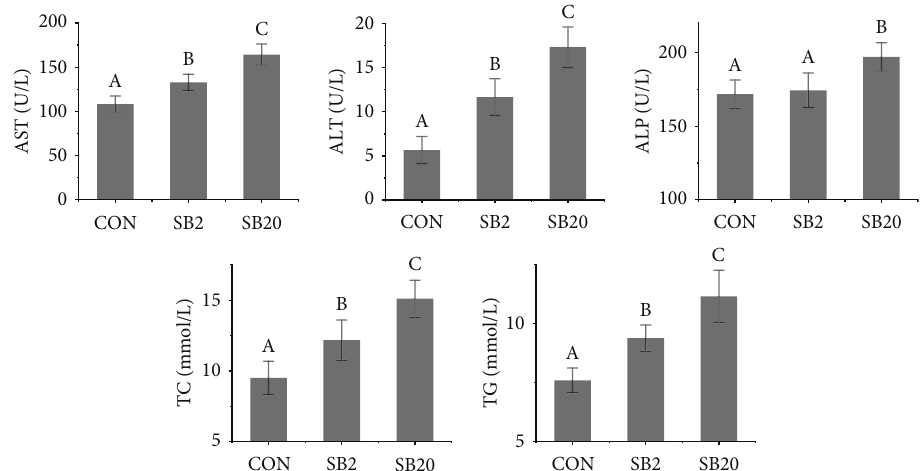
Figure 1: Four e ff ects of two dosages of sodium butyrate on serum biochemistry of largemouth bass, Micropterus salmoides. AST: aspartate aminotransferase; ALT: alanine aminotransferase; ALP: alkaline phosphatase; TC: total cholesterol; TG: total triglycerides. Di ff erent letters above the bars represent signi fi cant di ff erences ( P < 0 : 05 , n = 3 ).